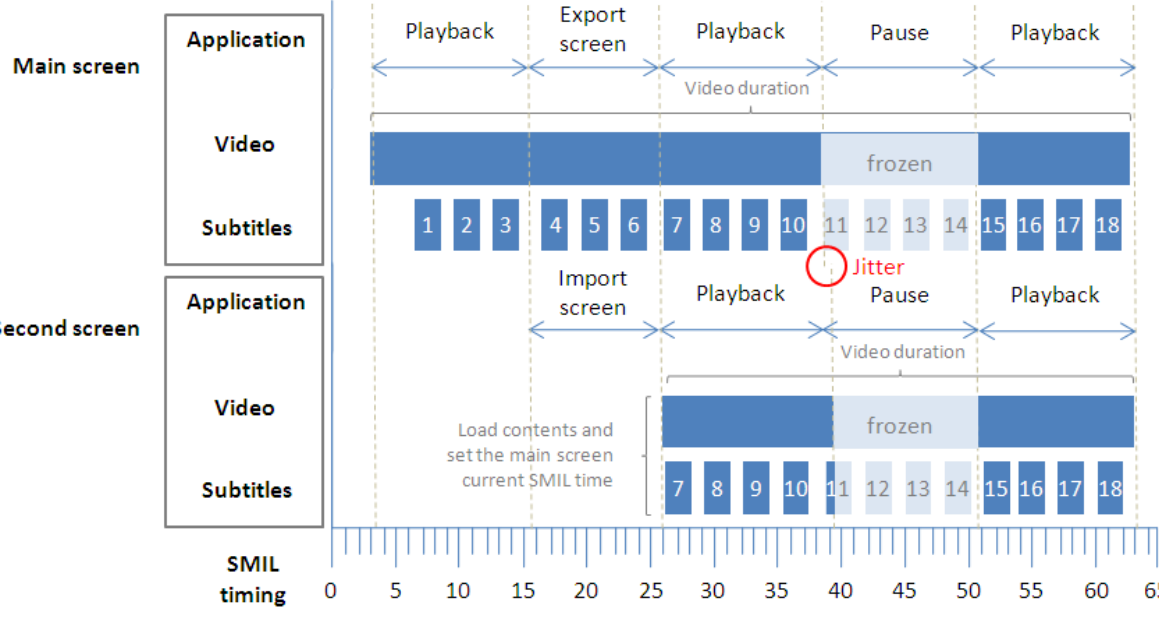
Figure 7. Strip diagram of basic timing support with a screen export operation for a second